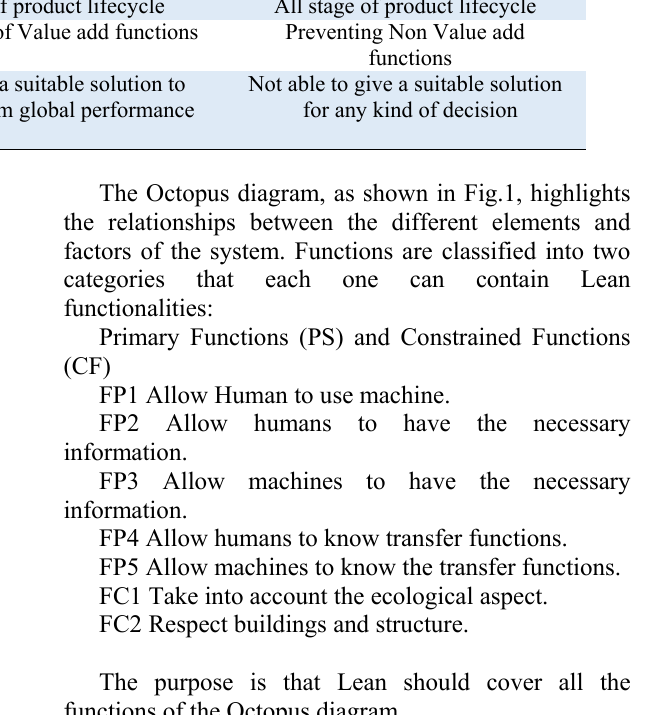
Table 3. Lean functionalities from different Lean paradigms Lean principles Related Lean Paradigm Process Lean And Six Sigma